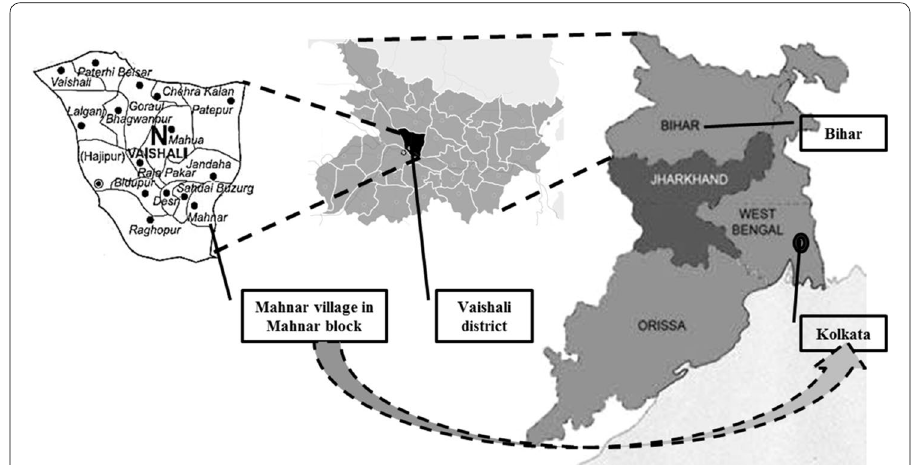
Fig. 2 Geographical locations of the places mentioned in the present study. Source : figure constructed by authors for representation only and is not to